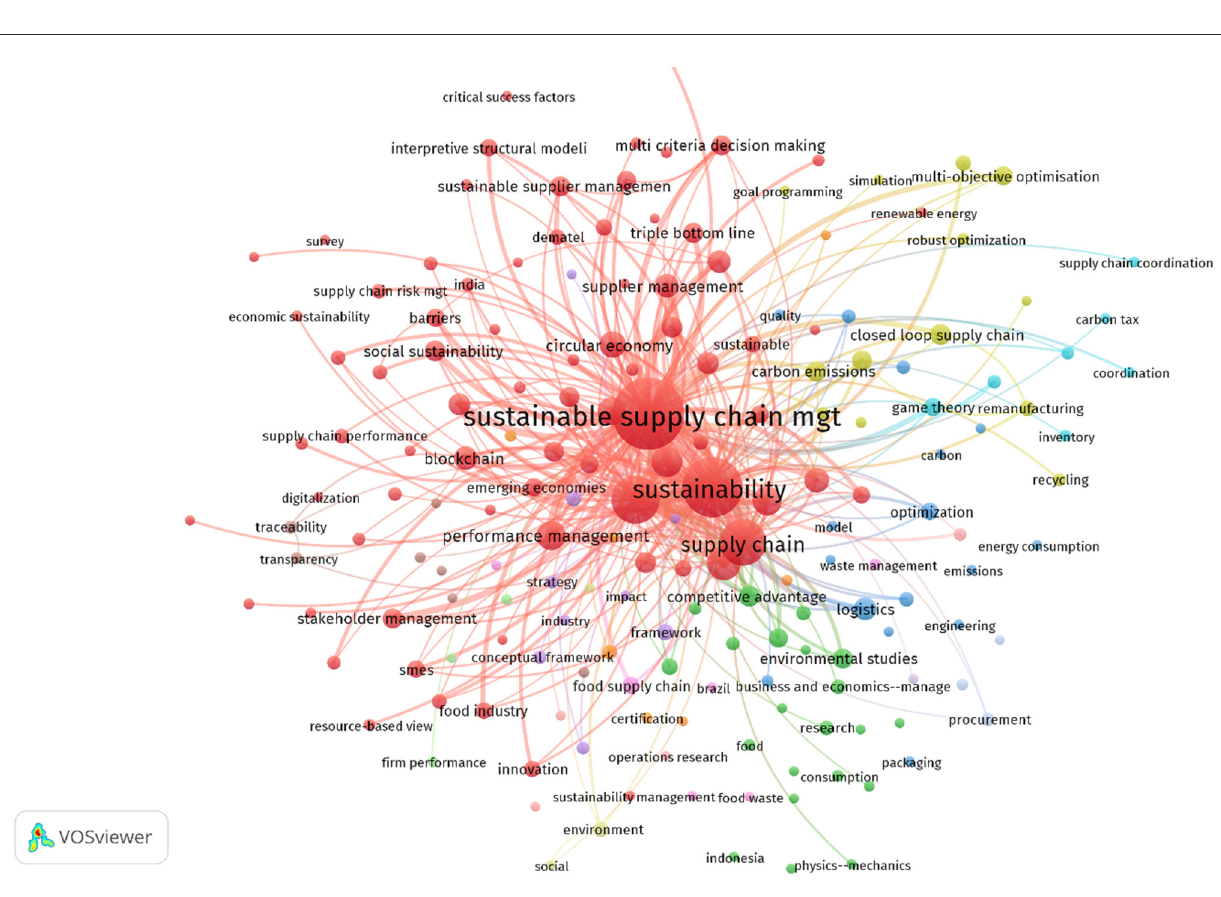
FIGURE6 Network visualization of keywords in Vosviewer.